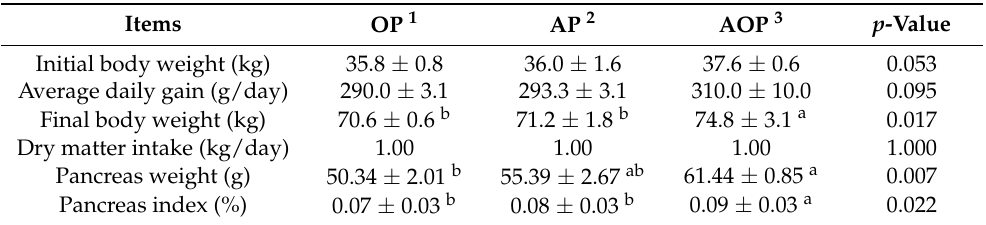
Table 2. Effect of different forage source diets on liveweight parameters and the pancreatic index of preweaning yak